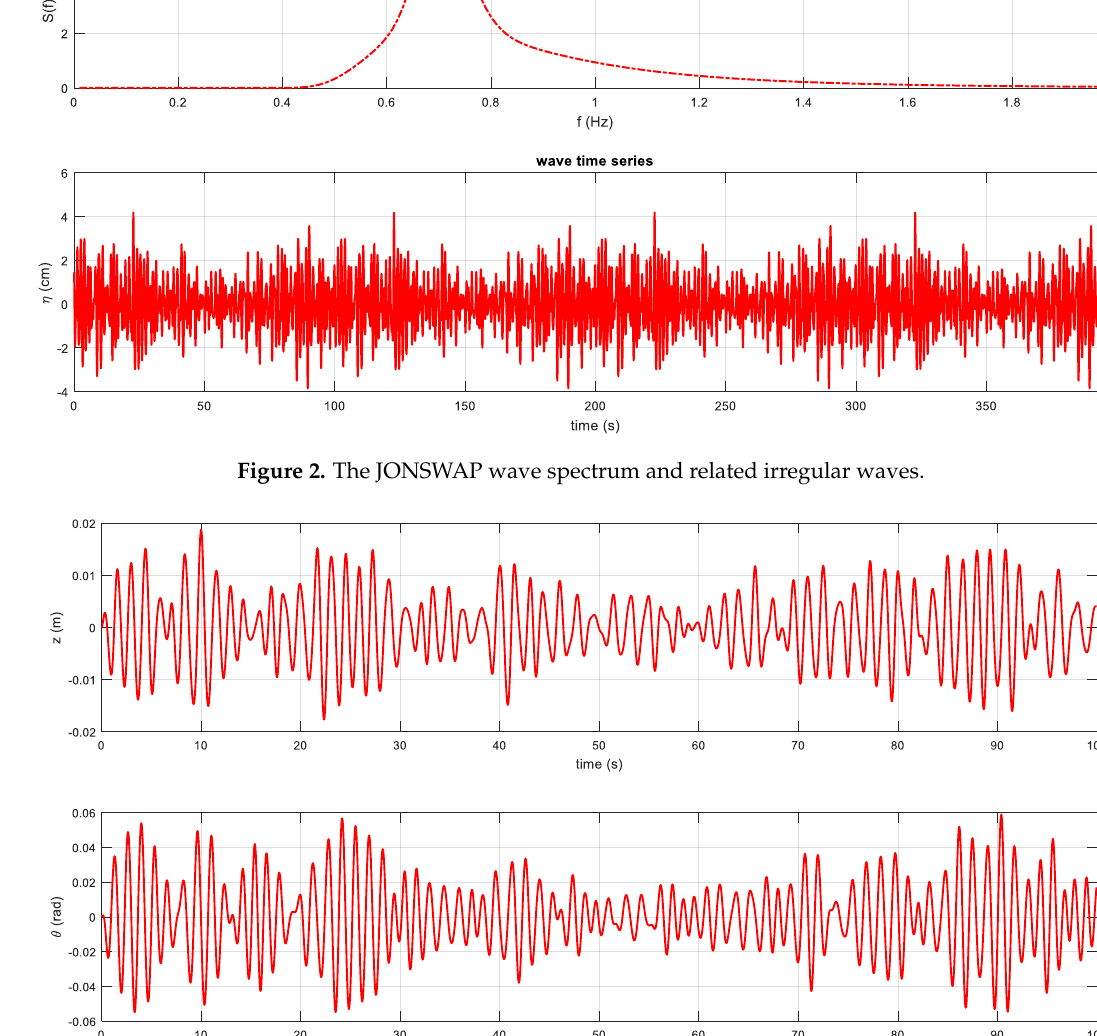
Table 3. The parameters in Equation (9).